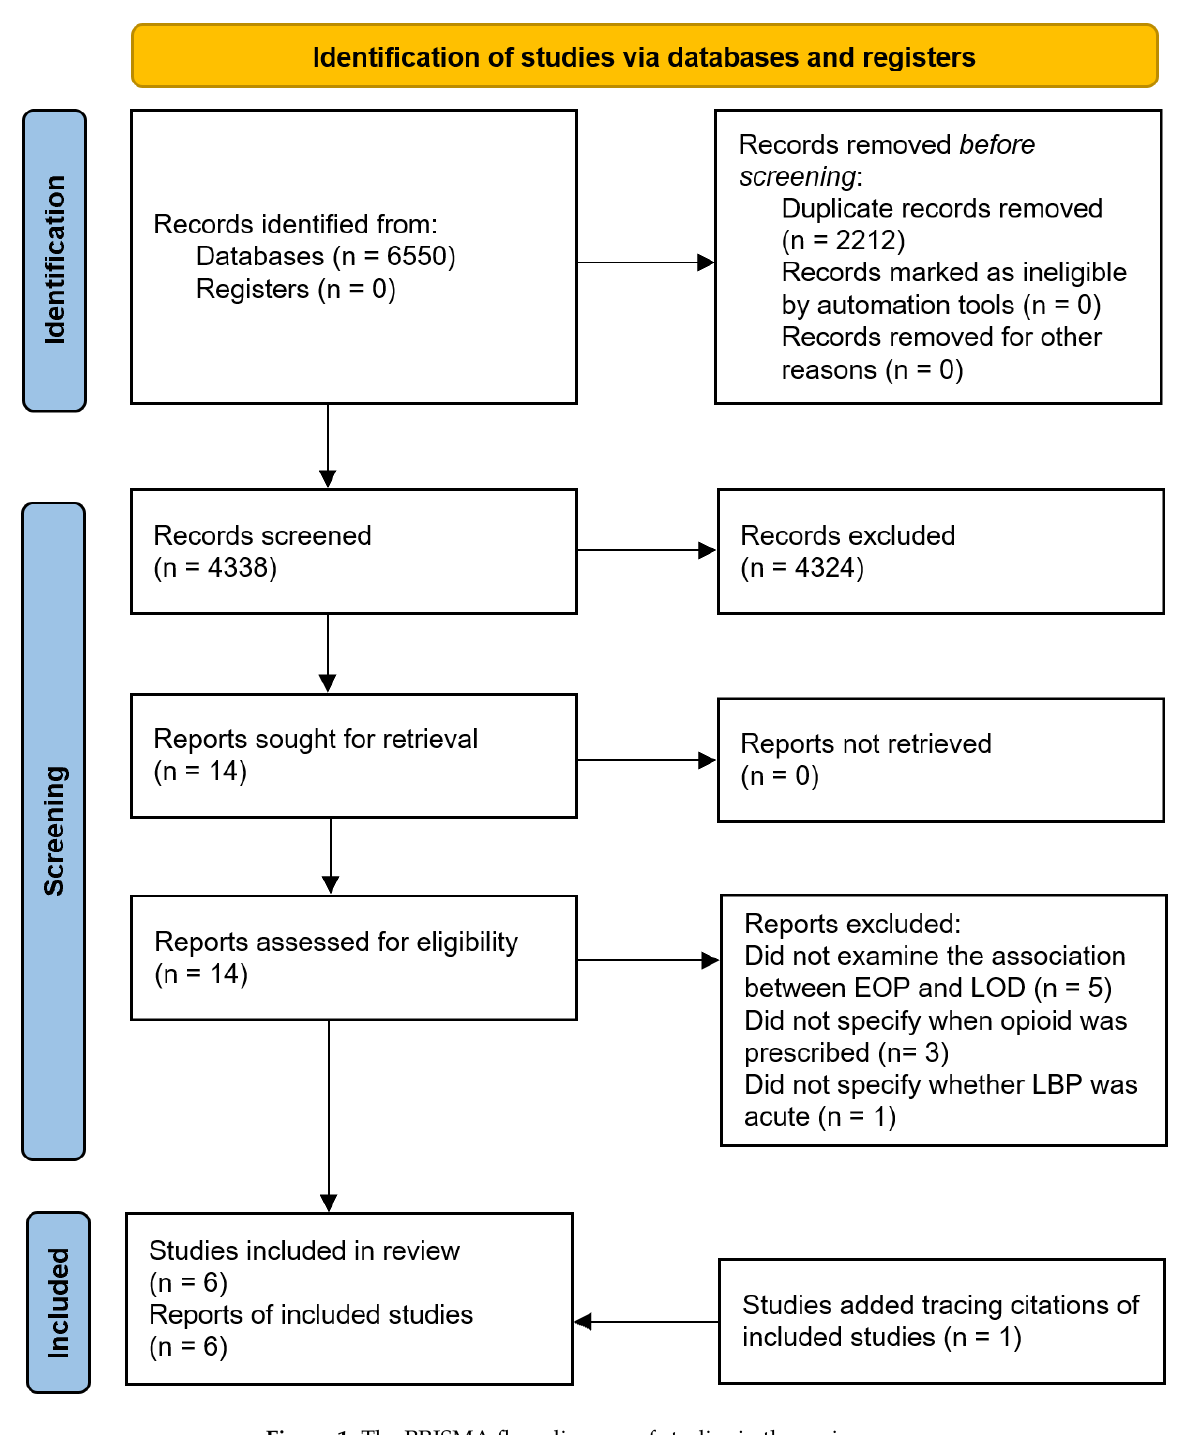
Figure 1. The PRISMA flow diagram of studies in the review.